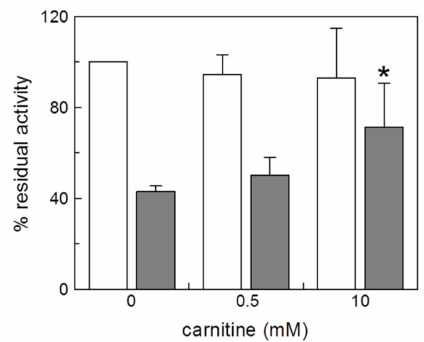
Figure 5. Protection by substrate of the CAC inhibition by Cu 2 + . Carnitine at the indicated concentrations was added to proteoliposomes, and then the mixture was incubated for 1 min with (grey bars) or without (white bars) the addition of 0.5 µ M CuCl 2 . Unreacted compound was removed by passing the proteoliposomes through Sephadex G-75 columns (see Materials and Methods). Transport was then started by adding 0.1 mM [ 3 H]carnitine to the proteoliposomes and stopped after 10 min. Percent residual activity is reported with respect to the control without the addition of CuCl 2 . The data are the means ± SD from three different experiments; significantly different from the respective control as estimated by the Student’s t test (* p < 0.05).